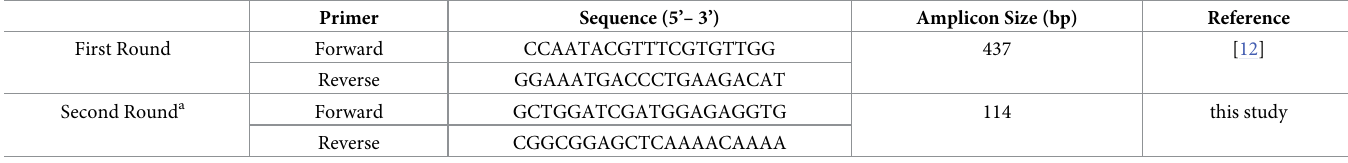
Table 1. Sequences of primers used in this